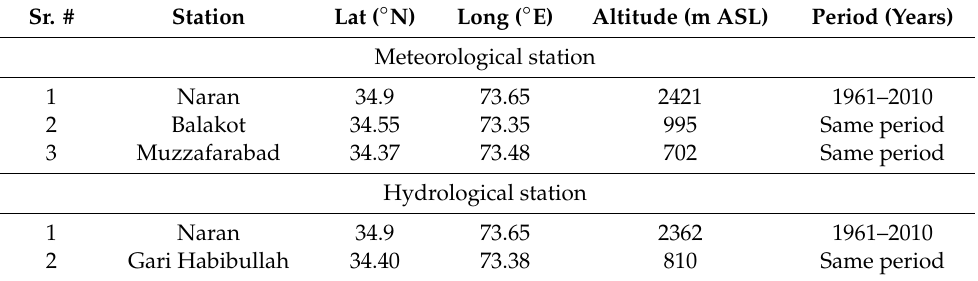
Figure 1. High altitude catchment of western Himalaya, Pakistan. Table 1. Hydro-meteorological stations in the study area.